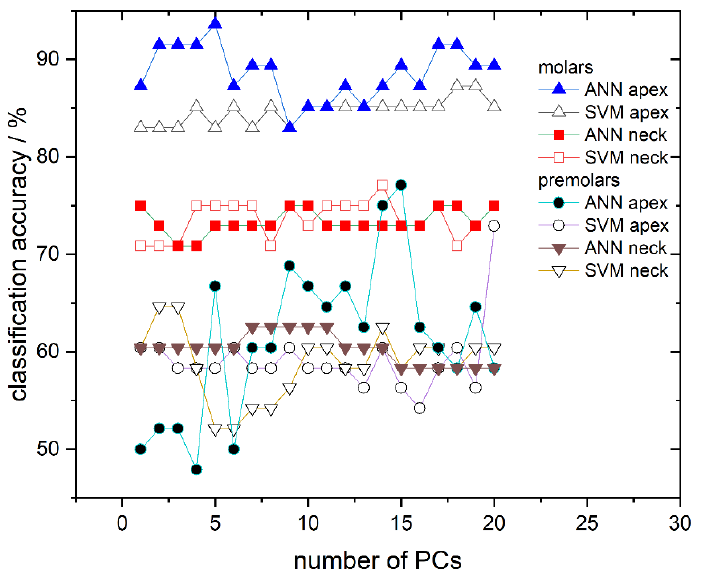
Figure 6. Classification accuracy obtained by ANN and SVM in dependence on the number of used PCs for all calculated models: Molar apex and molar anatomical neck; premolar apex and premolar anatomical neck. Lines between symbols were added as a visual aid.